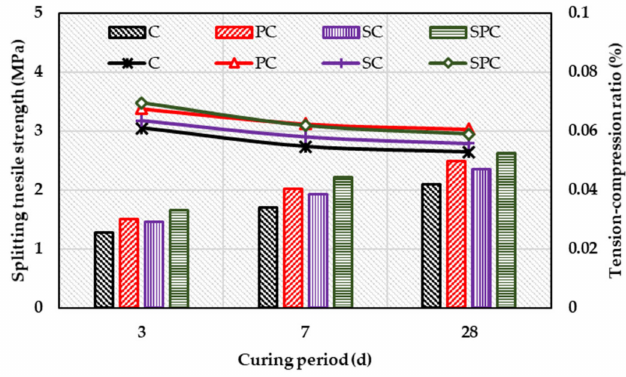
Figure 12. Splitting tensile test results of impermeable concrete.